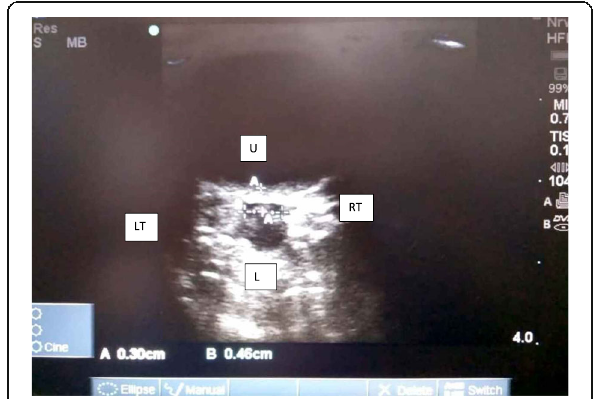
Fig. 3 Ocular sonography image showing optic nerve sheath diameter of left eye ( a , cursor points; b optic nerve sheath diameter; U, upper; L, lower; Lt left; Rt,